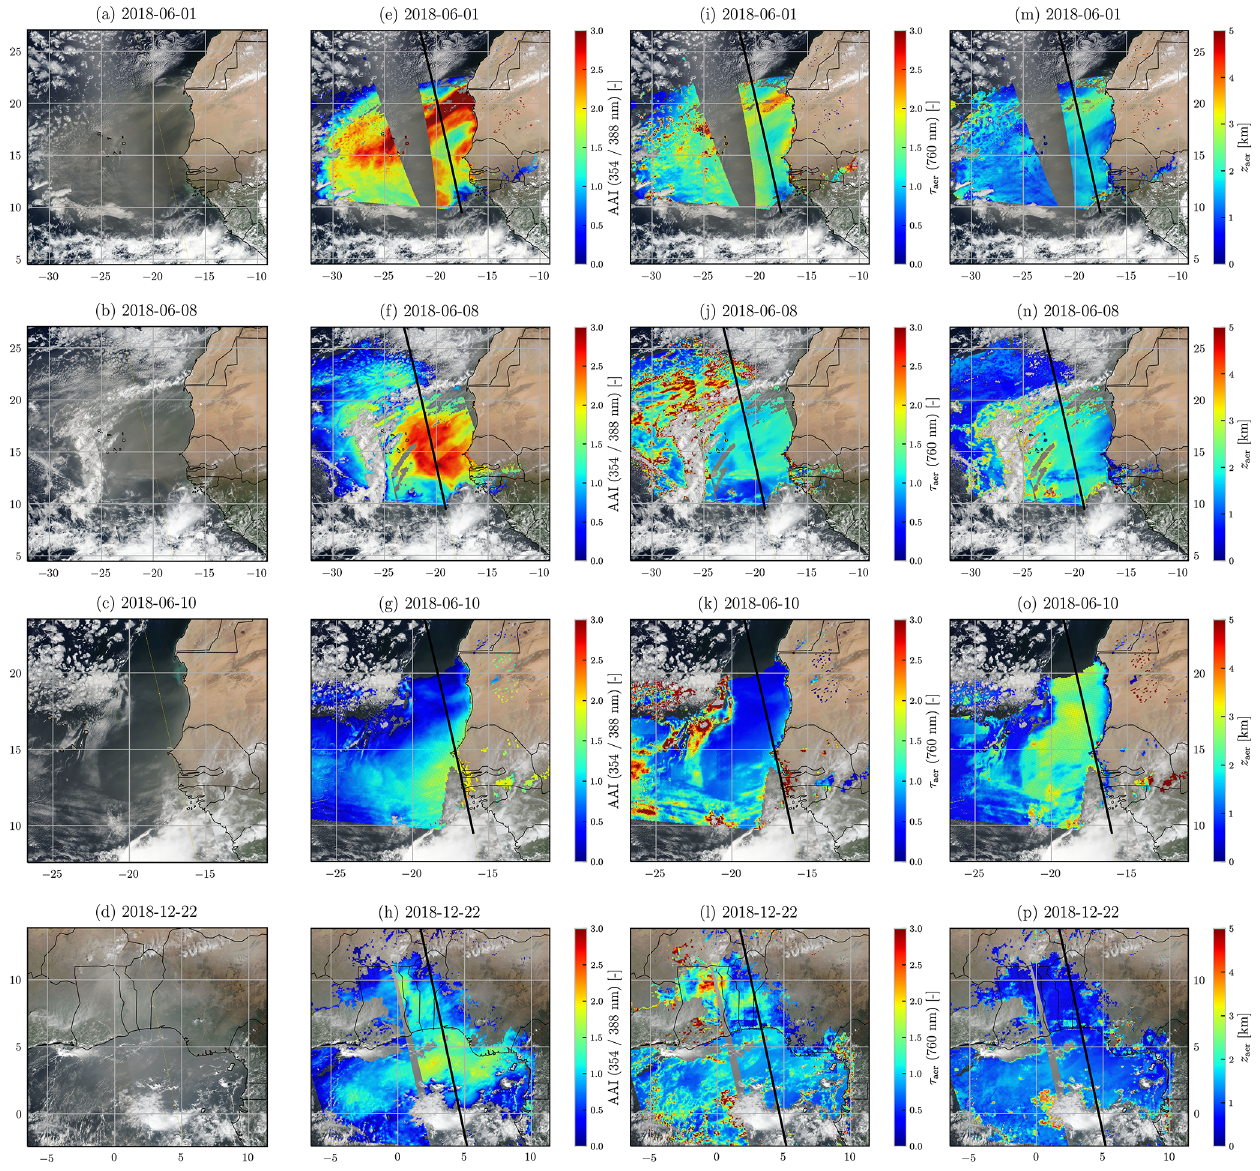
Figure 5. First column: corrected reflectance for the four selected cases as measured by the Suomi NPP/VIIRS imager. The yellow line represents the CALIOP ground track. Second column: the TROPOMI level-2 UV aerosol index product. The black line passing through the TROPOMI level-2 retrievals on this plot represents the ground track of the CALIPSO mission. Third column: retrieved AOT from TROPOMI. Fourth column: operational TROPOMI